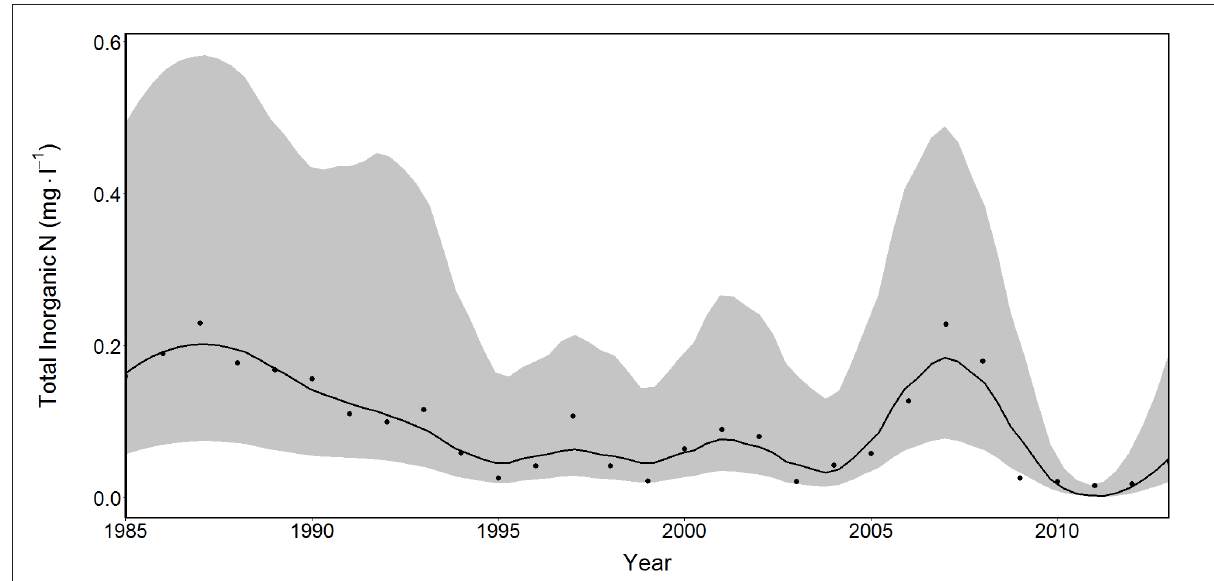
Annual median total inorganic nitrogen levels in South African fresh water plotted against time. The points show median dissolved total inorganic nitrogen (as mg N/L) per year; the line is a loess smoother; and the grey ribbon spans the 25th to 75th percentiles.